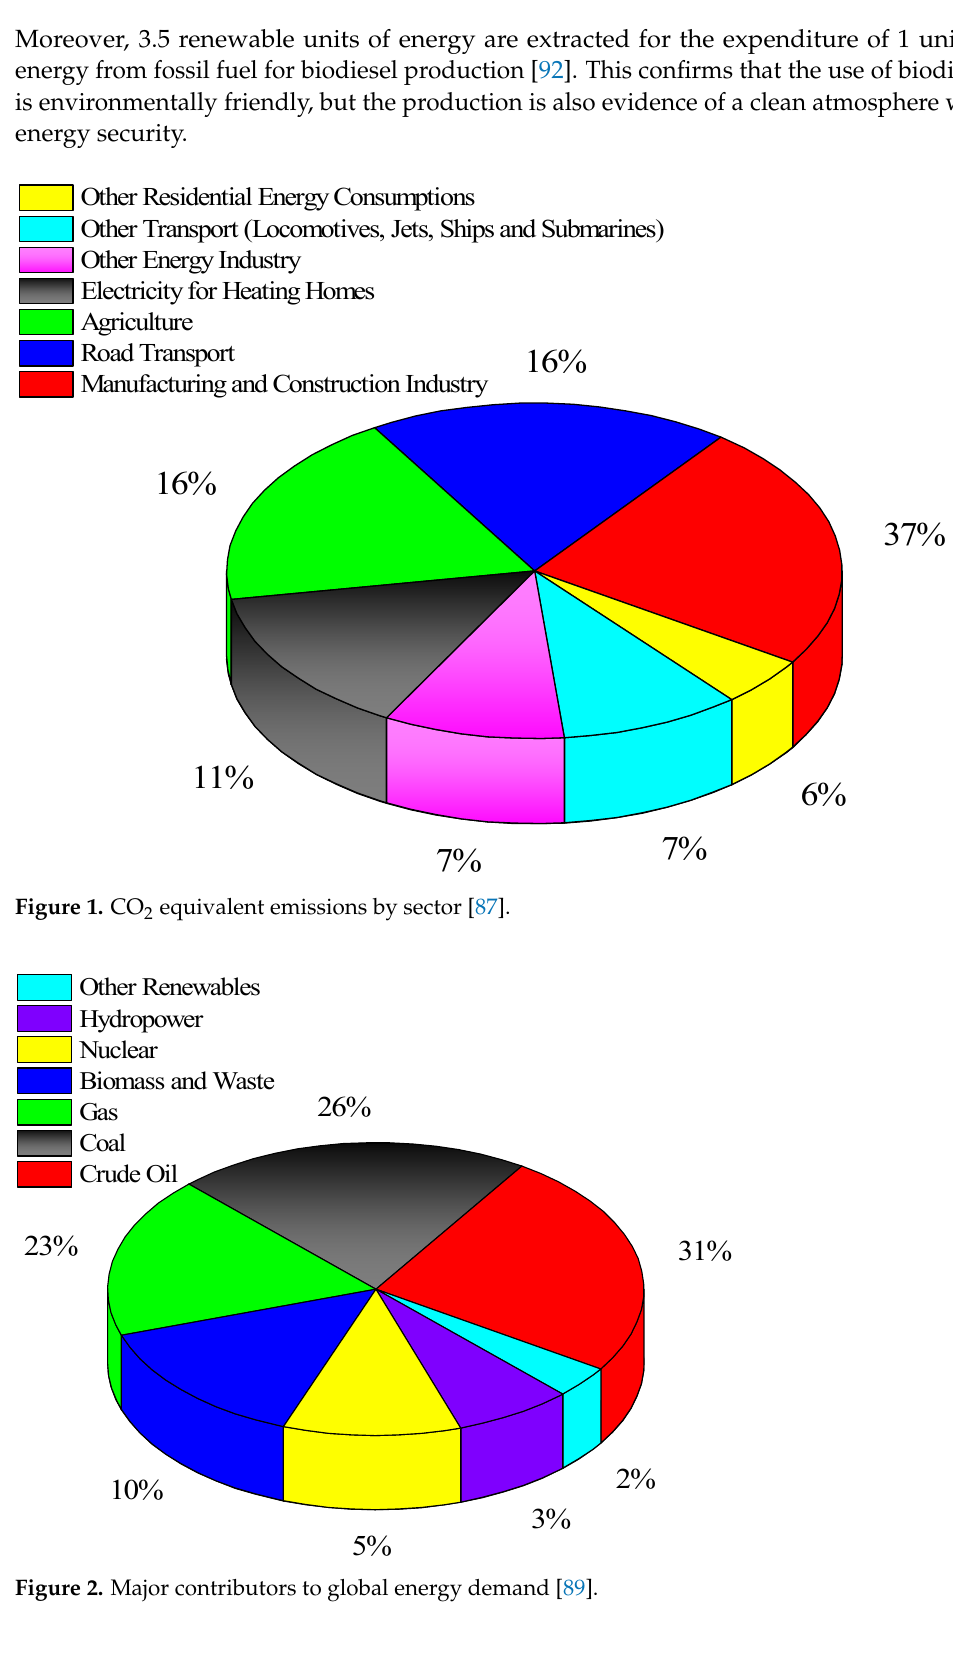
Figure 2. Major contributors to global energy demand [89].